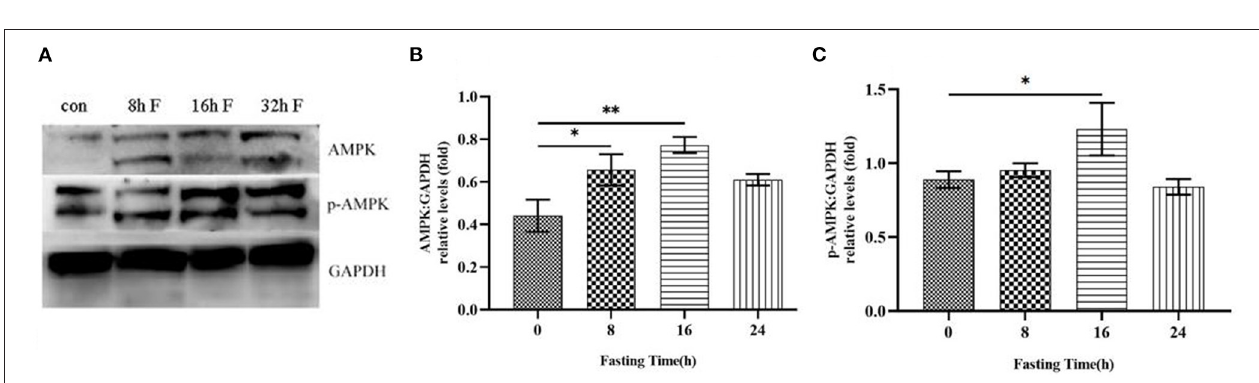
FIGURE 3 | Effects of Cidec overexpression on the lipid droplet morphology in AML12 cells. (A) Representative images of lipid droplets in AML12 cells transfected with pIRES2-EGFP and pIRES2-EGFP-Cidec. Cells were stained with oil red O and counterstained with DAPI. GFP signal (green), oil red O (red), DAPI (blue). Scale bar, 10 µ m. (B) The diameter of lipid droplets were measured in AML12 cells transfected with pIRES2-EGFP and pIRES2-EGFP-Cidec. (C) The nunmber of lipid droplets were quantified in AML12 cells transfected with pIRES2-EGFP and pIRES2-EGFP-Cidec. Data in (B,C) were analyzed by t-test. ** P < 0.01.